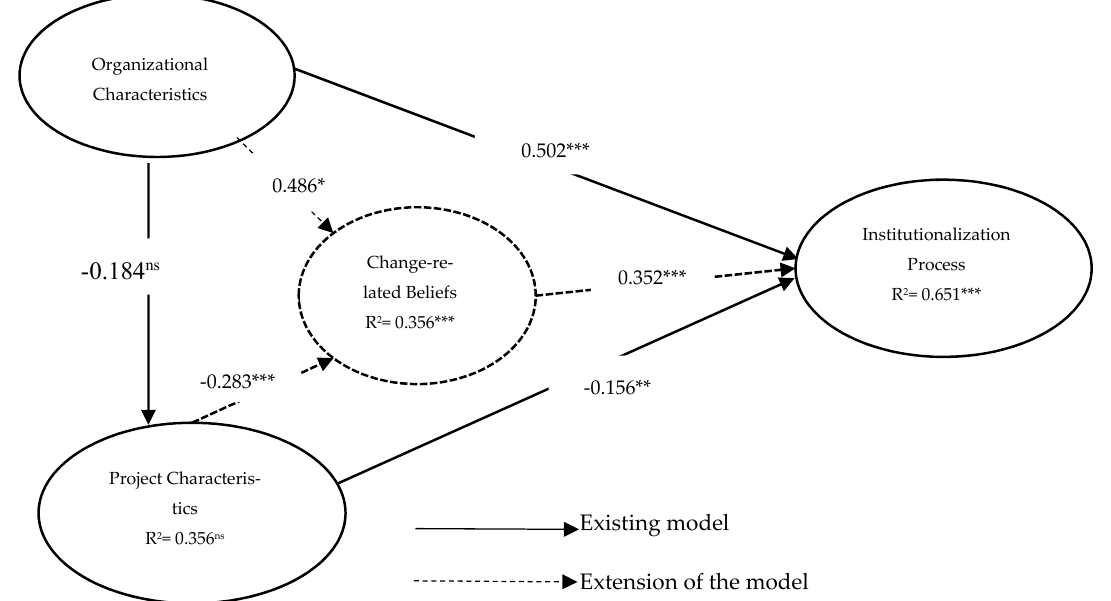
Figure 1. Structural model exhibiting the relationship between study constructs. * p < 0.05; ** p < 0.01; *** p < 0.000; ns—non-significant.